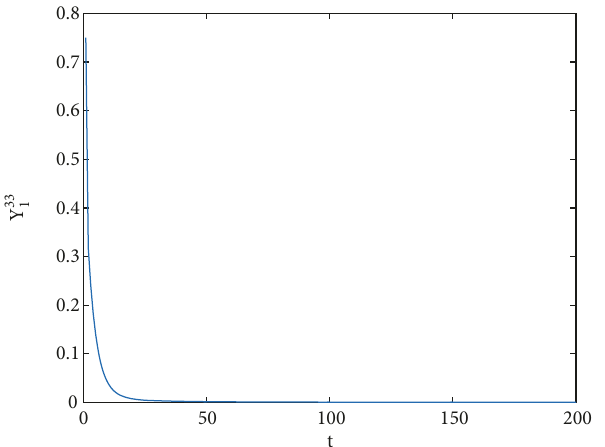
Figure 1: Parameter estimation covariance of sensor 1.